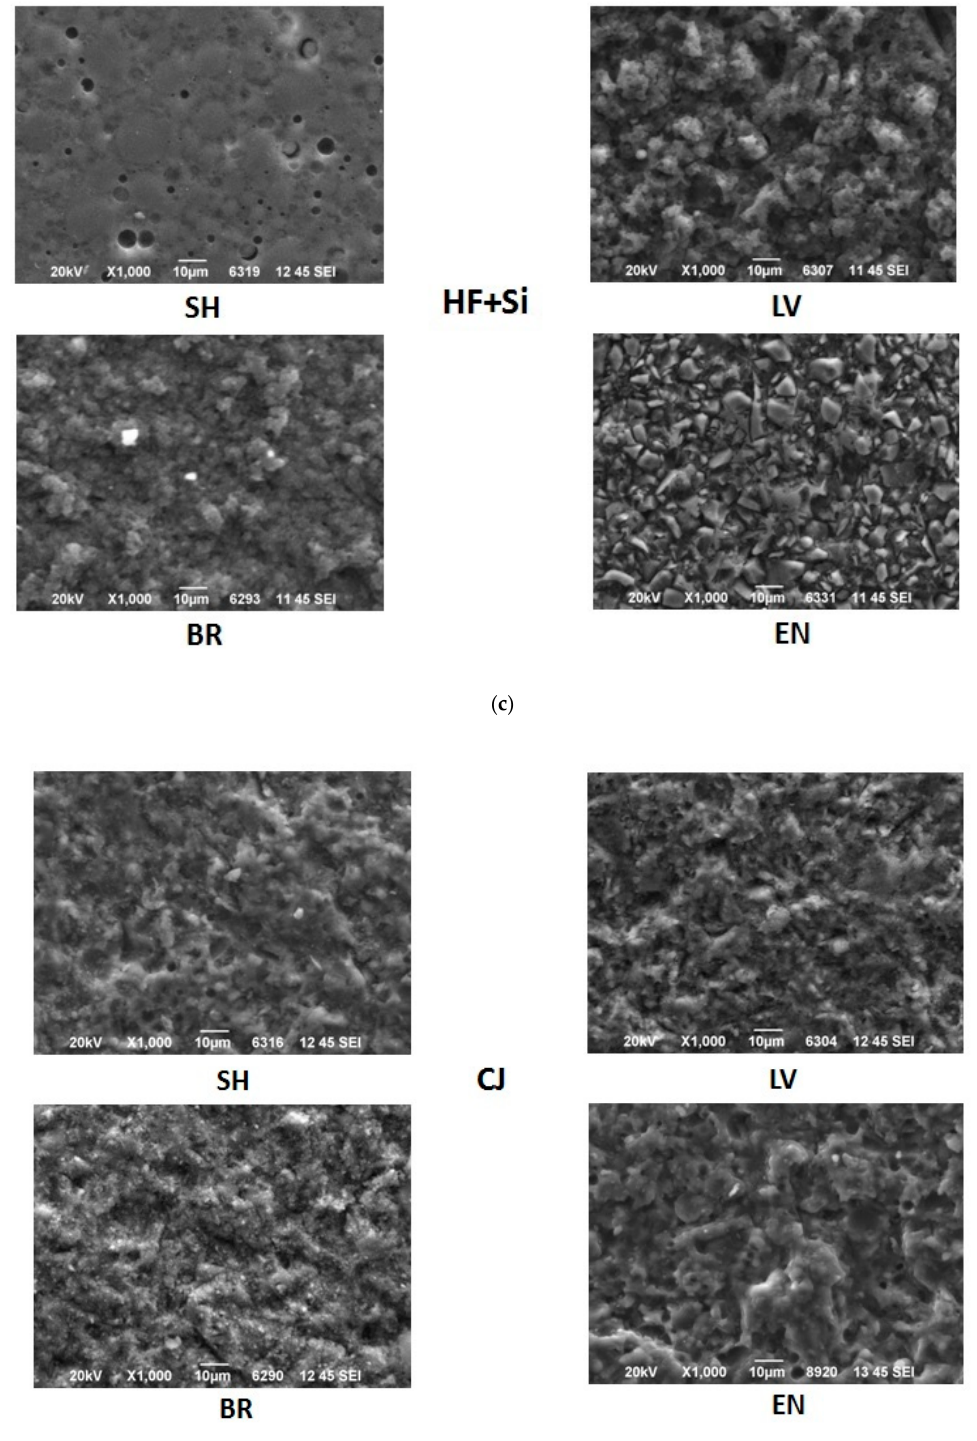
Figure 7. ( a ) Representative scanning electron microscope (SEM) images of the intact surfaces of the tested CAD / CAM materials. ( b ) Representative SEM images of the surfaces of the tested CAD / CAM materials after sandblasting with 29 µ m Al 2 O 3 particles. ( c ) Representative SEM images of the surfaces of the tested CAD / CAM materials after HF + Si treatment. ( d ) Representative SEM images of the surfaces of the tested CAD / CAM materials after sandblasting with the CoJet